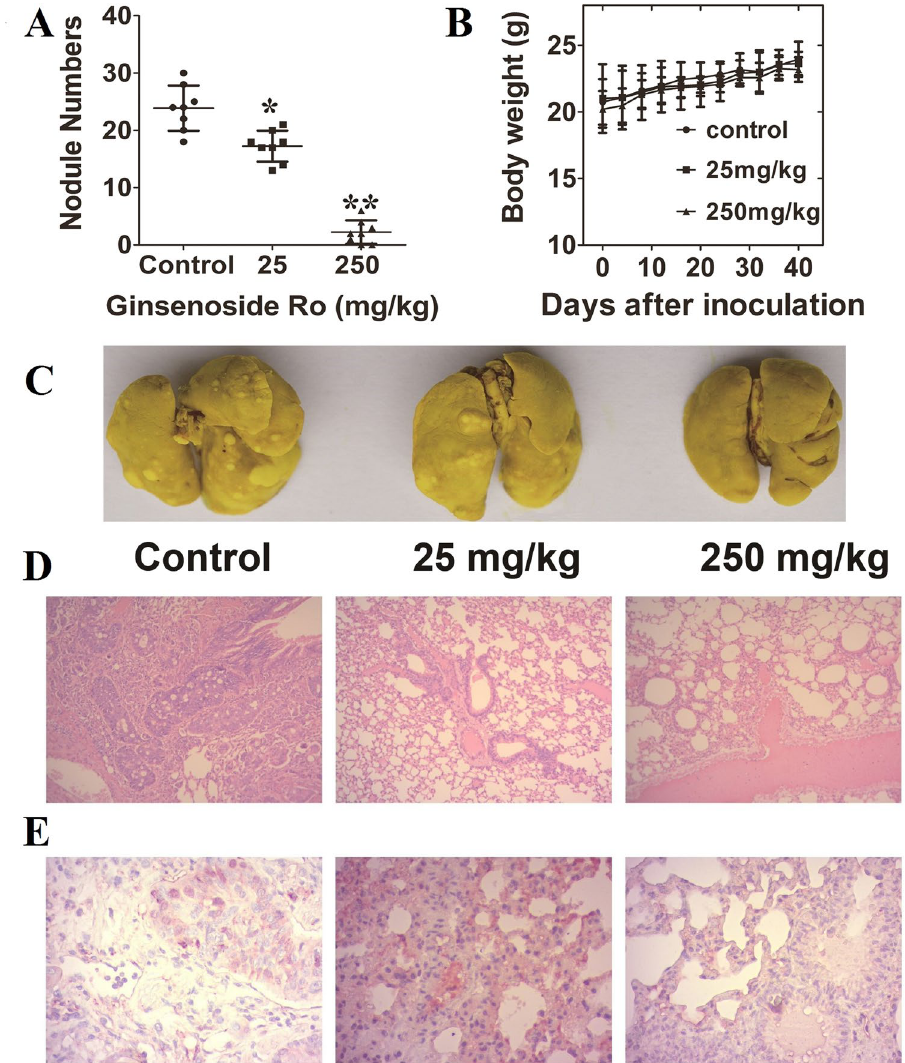
Figure 6. Effect of oral ginsenoside Ro on lung metastasis induced by HT29 cells tail-injected into female Balb/c nude mice. ( A and B ) Four-day pretreatment with ginsenoside Ro before HT29 injection followed by the same treatment for 40 days significantly reduced the number of tumor nodules on the mouse lung surface without affecting the mouse body weight in comparison with the untreated control. ( C ) Representative images of the lungs taken from different treatment groups. ( D ) H&E staining of the paraffin-embedded lungs showed a decrease in metastatic foci by ginsenoside Ro dose-dependently. ( E ) Immunohistochemical staining showed the expression of integrin α v β 6 in mouse lungs was reduced by ginsenoside Ro dose-dependently. Data represent the mean ± SD (n = 10 per group). * P < 0.05, and ** P < 0.01, compared with the